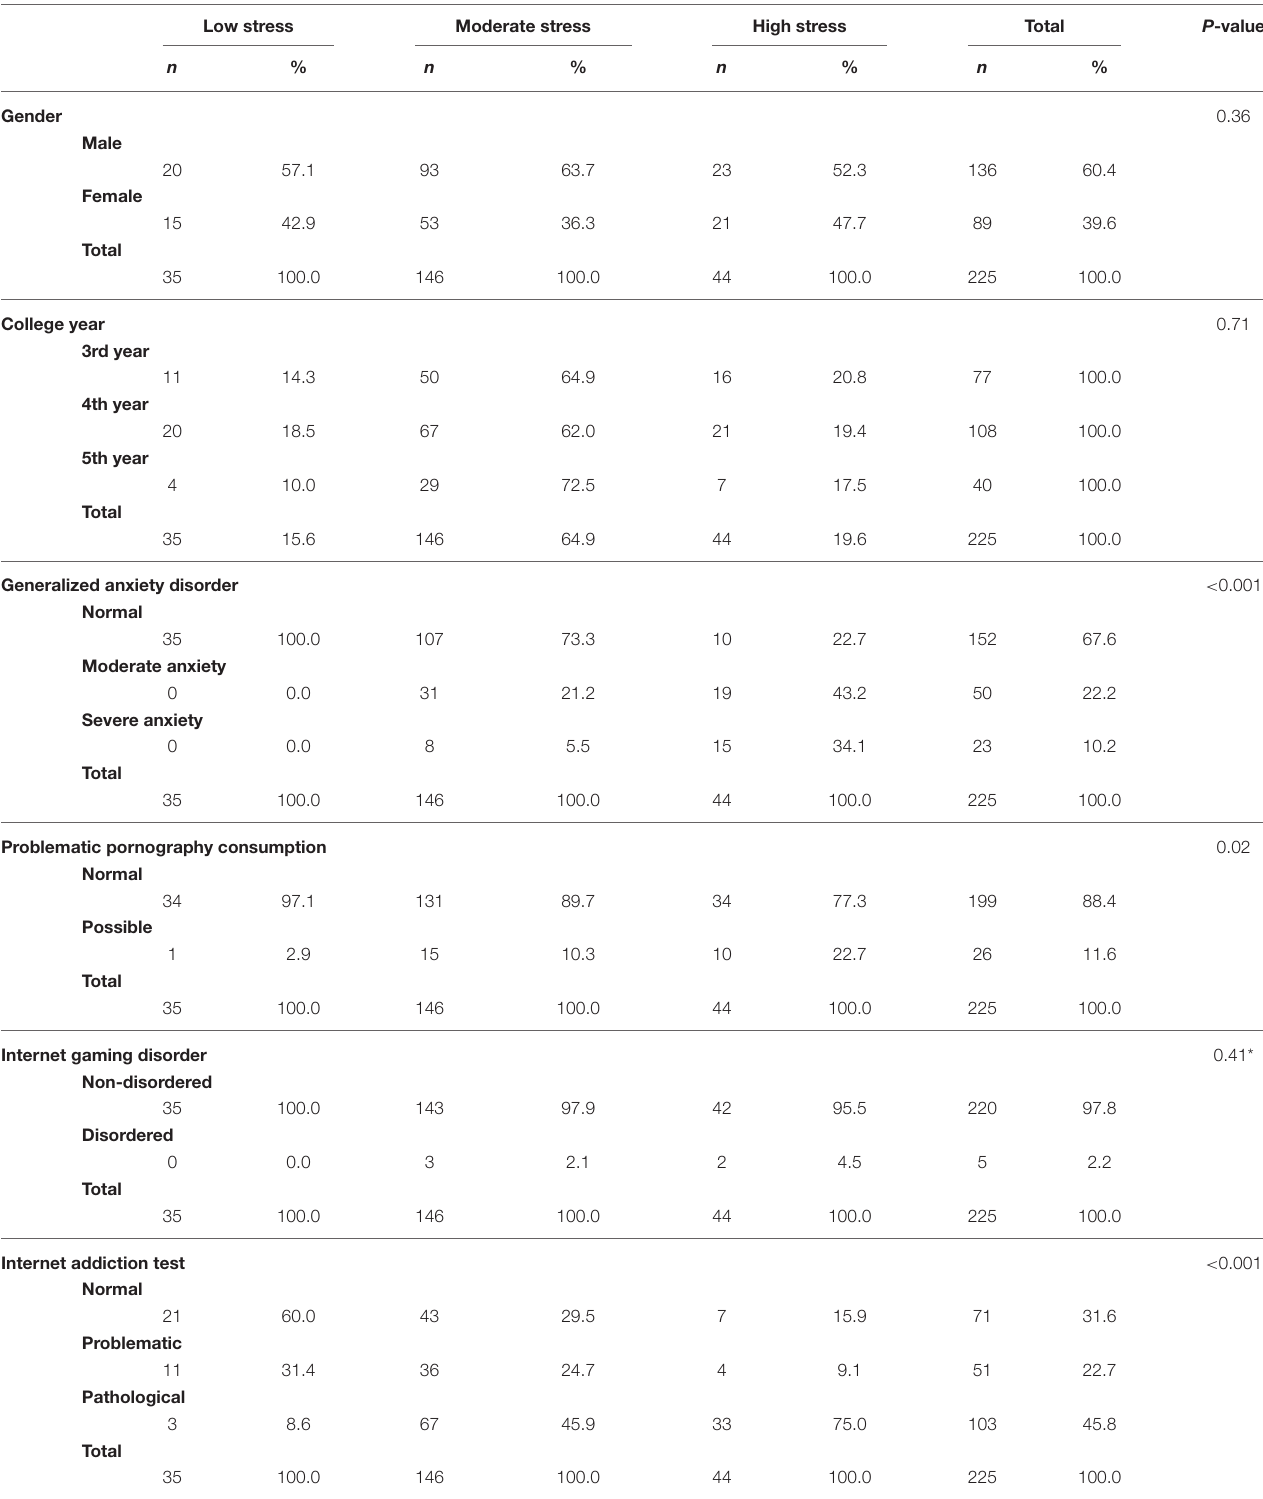
TABLE 3 | Association between different behavioral addictions and stress. Low stress Moderate stress High